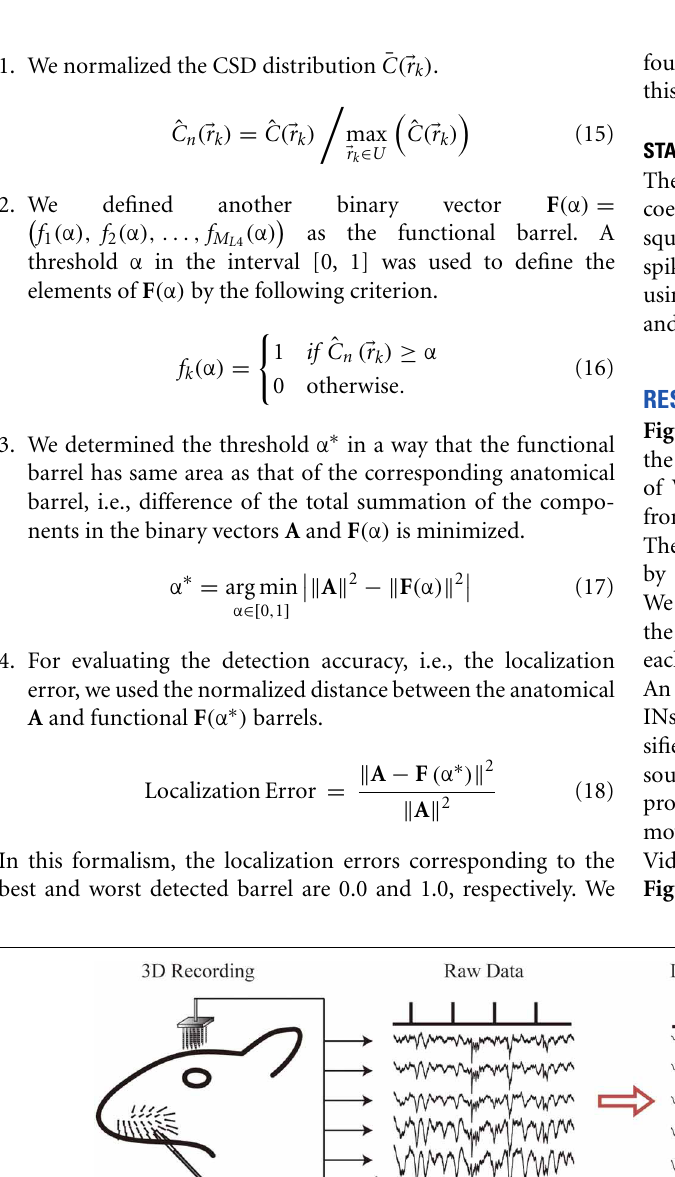
average of the electric potentials (STAPs) for pyramidal cells (PCs) and interneurons (INs) are obtained through spike detection and clustering methods. Finally, the vCSD method is applied to the STAPs as well as to the averaged (ERPs) and single trial LFPs to estimate the spatiotemporal CSD maps associated with single unit activities and population inputs,